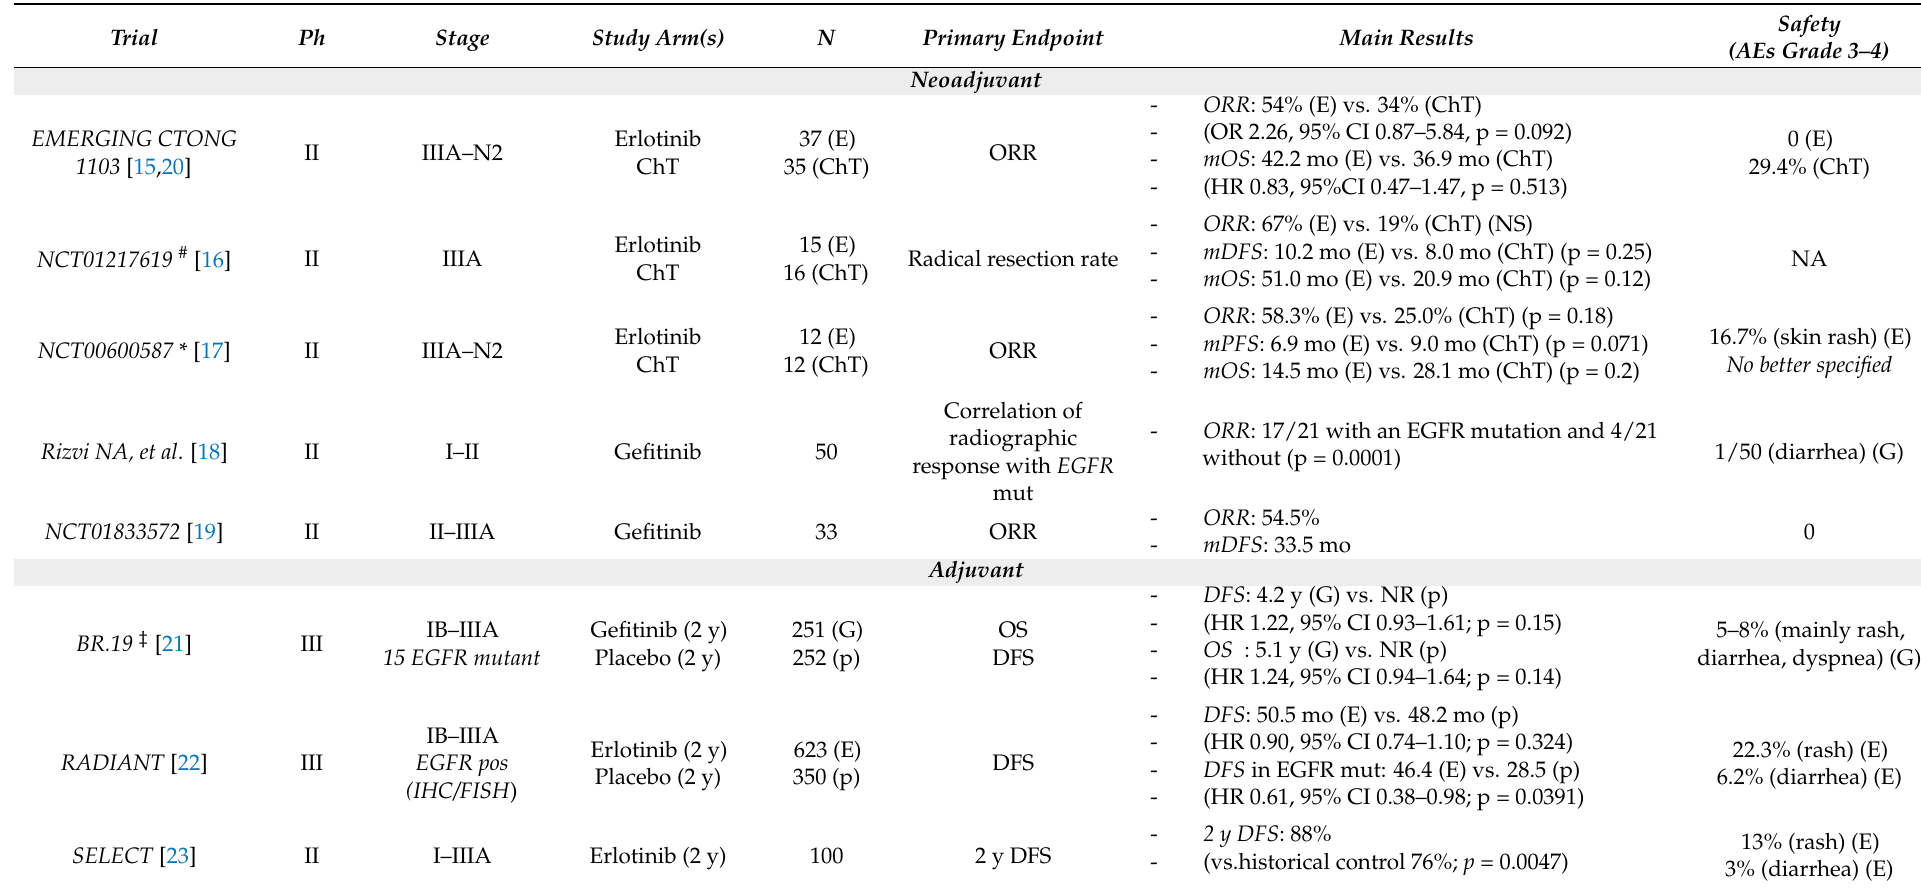
Table 1. Main neoadjuvant and adjuvant clinical trials testing EGFR TKIs in